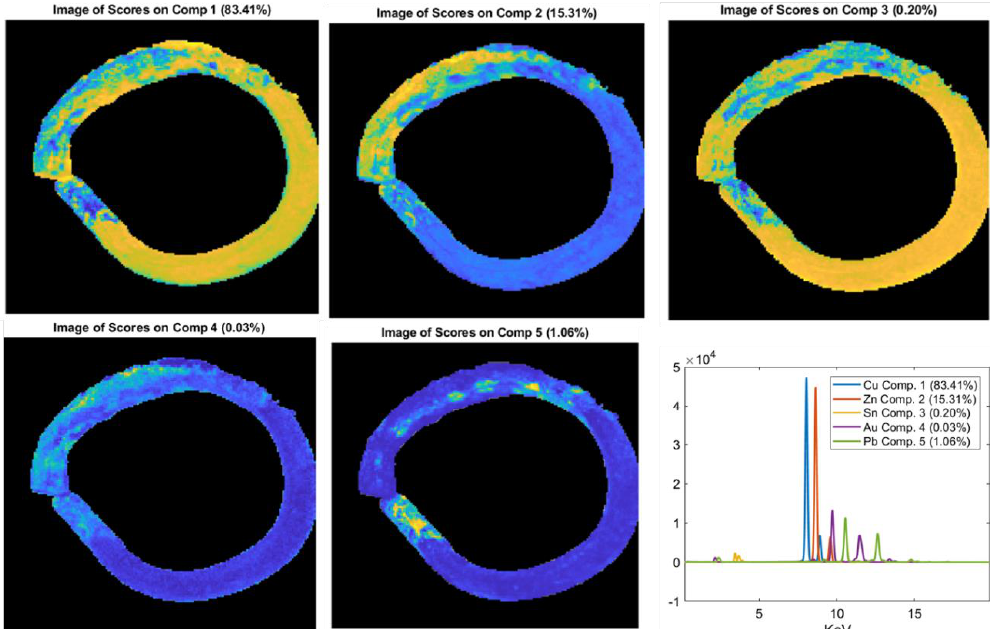
Figure 12. Multivariate curve resolution (MCR) analysis on the XRF spectra of the object 5085_6. Cu and Sn are uniformly distributed in the alloy (Comp. 1 and Comp. 3), while Zn (Comp. 2) is concentrated in a defined area. Traces of gold are confirmed (Comp. 4), and in a little area of the surface, a high concentration of Pb is obtained (Comp. 5).